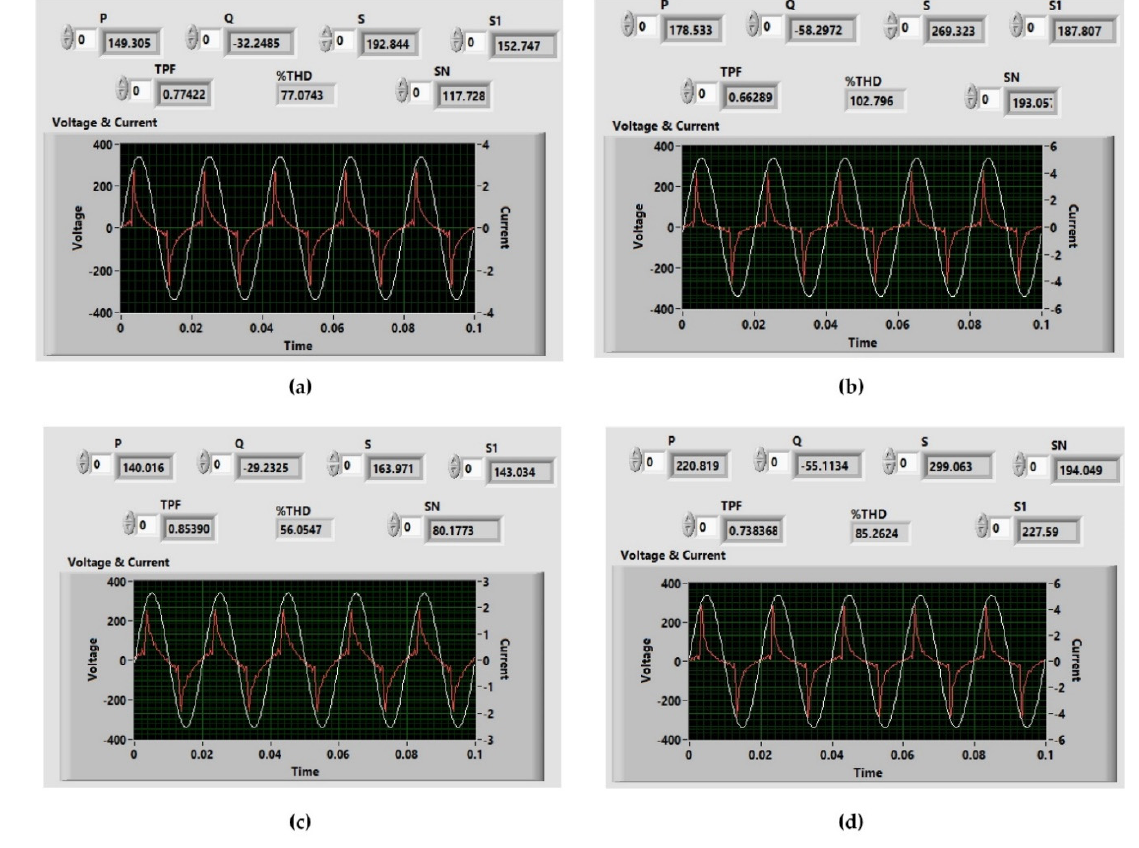
Figure 7. The voltage and current waveforms of combinations of three real-world appliances: ( a ) CFL + LED + exhaust fan; ( b ) CFL + LED + SMPS of a PC; ( c ) LED + exhaust fan + SMPS of a PC; ( d ) CFL + exhaust fan + SMPS of a PC.